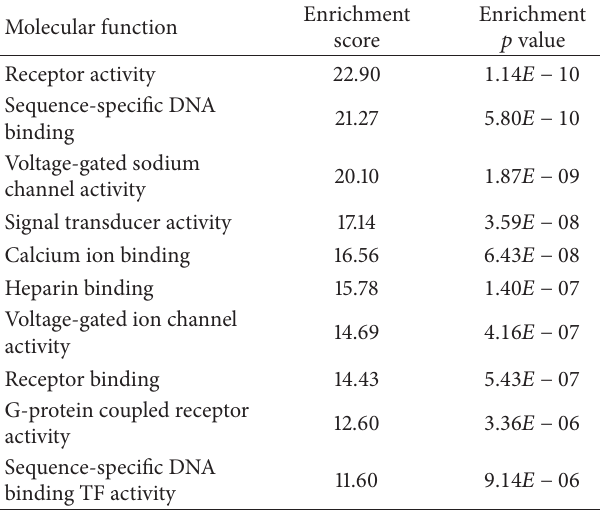
Table 1: Biological process: SEMA6D high versus low comparison.